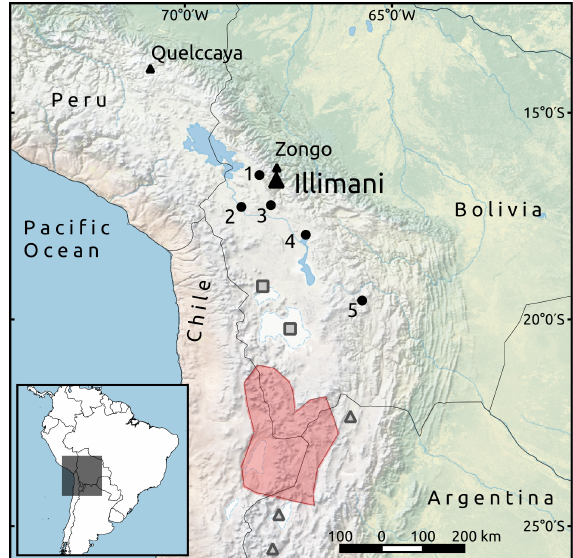
Figure 1. Location of Nevado Illimani, the Zongo Valley, and the Quelccaya Ice Cap. The numbers indicate the location of the me- teorological stations used for comparison with our results: 1 – El Alto; 2 – Calacoto; 3 – Patacamaya; 4 – Oruro; and 5 – Potosi. The red area indicates the Altiplano-Puna Volcanic Complex (Lind- say et al., 2001). The gray squares and gray triangles denote po- tential dust source areas in the salars of the Altiplano and in the Puna, respectively (Gaiero et al., 2013). The land basemap was de- rived from satellite data (Natural Earth I with shaded relief from http://www.naturalearthdata.com, last access: 12 October